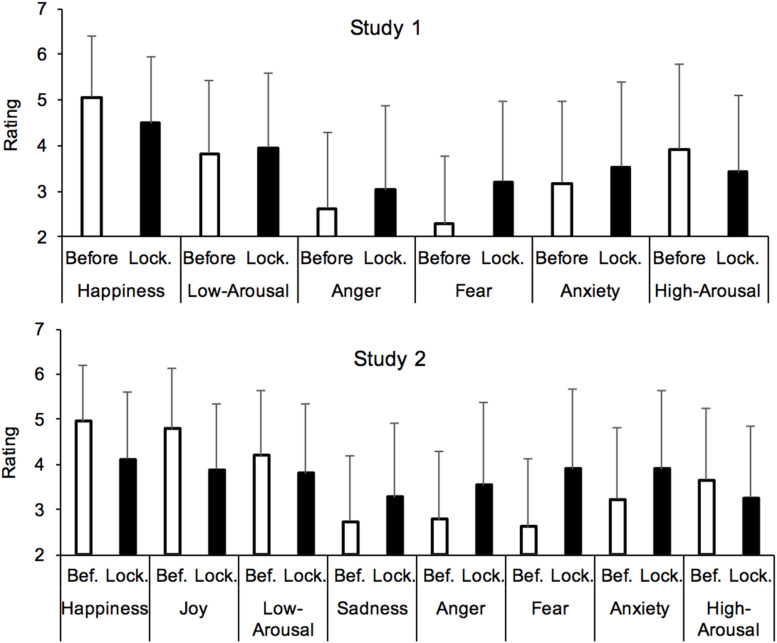
Mean rating of emotions felt before and during the lockdown.